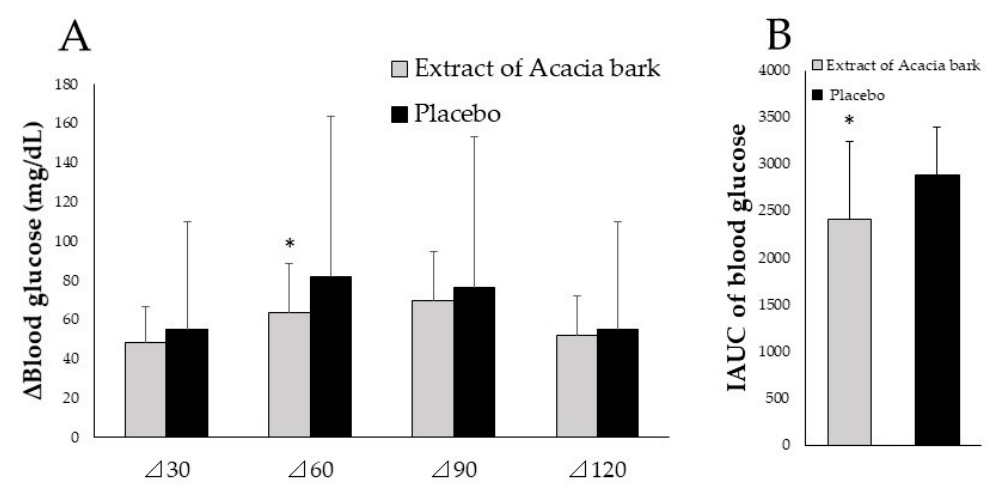
Figure 4. The amount of change in the plasma glucose concentration ( A ) and incremental area under the curve of blood glucose (0–60 min) ( B ) of non-diabetic individuals administered cooked rice. Each bar represents the mean for 13 non-diabetic individuals ± standard deviation. □ Extract of Acacia bark, ■ Placebo * Significantly different from placebo p < 0.05 (Students’ t -test)